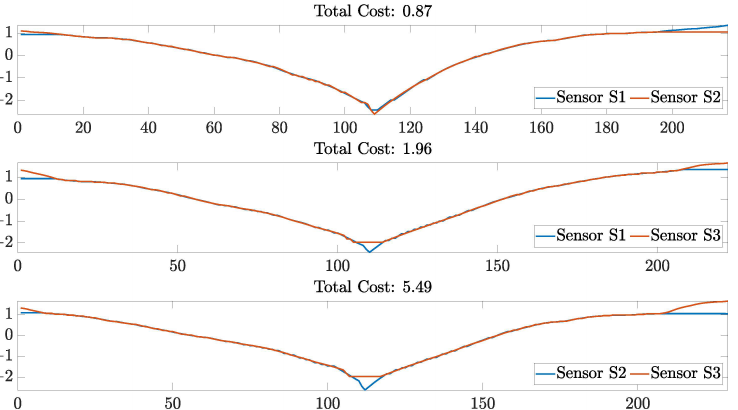
Figure 19. Data similarities assessed by applying the DTW technique on the resistance data of each sensor pair for Cycle 10. The y axis on each plot represent the normalized resistance data; and the x axis on each plot represents the resistance sample number compared during the computation of the warping path of the DTW